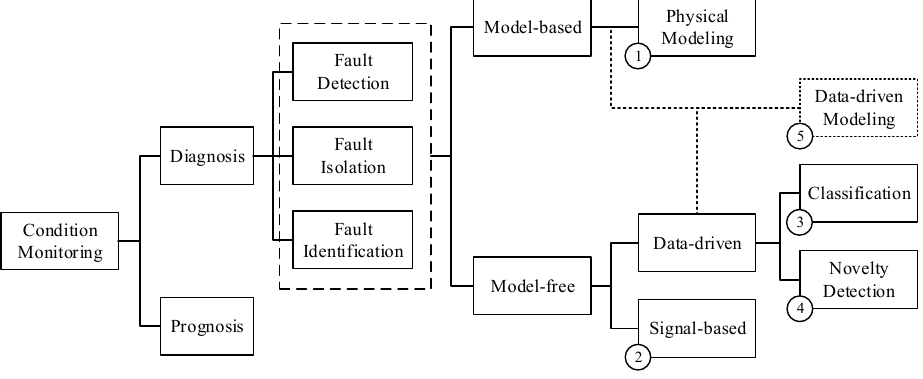
Figure 3. Elements of condition monitoring and classification of fault diagnosis approaches.